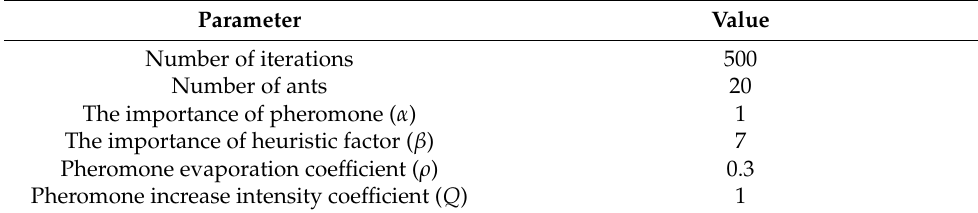
Table 2. IMACO algorithm